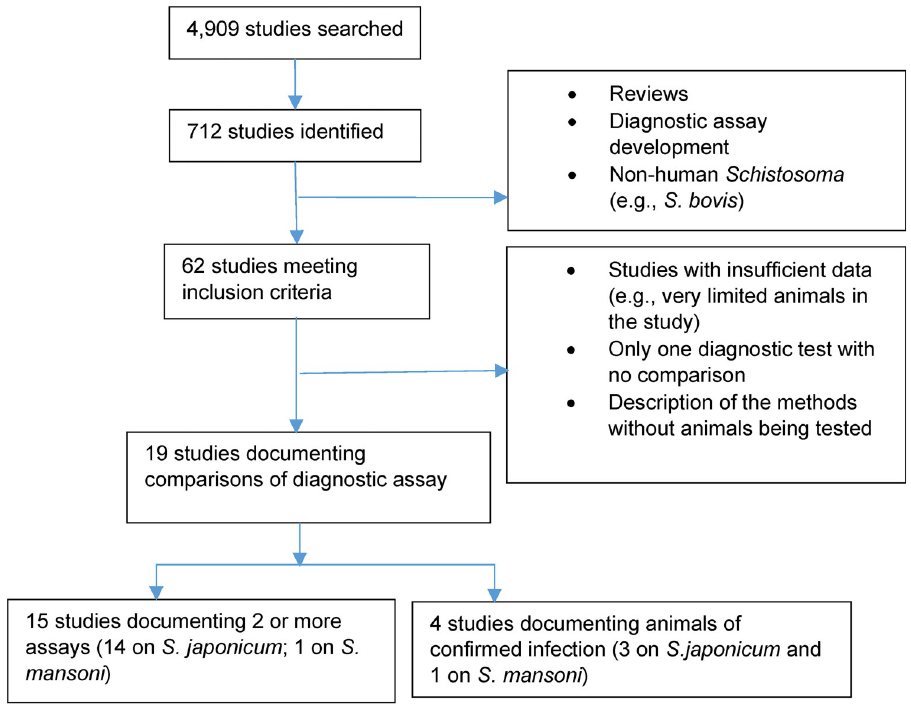
Fig 1. Inclusion and exclusion of studies on diagnosis of Schistosoma infections in animals and search